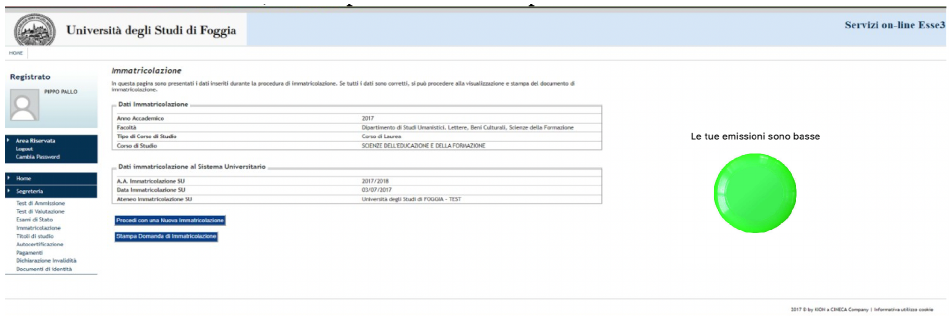
Figure 2. Example of display of the equivalent CO 2 level via the Esse3